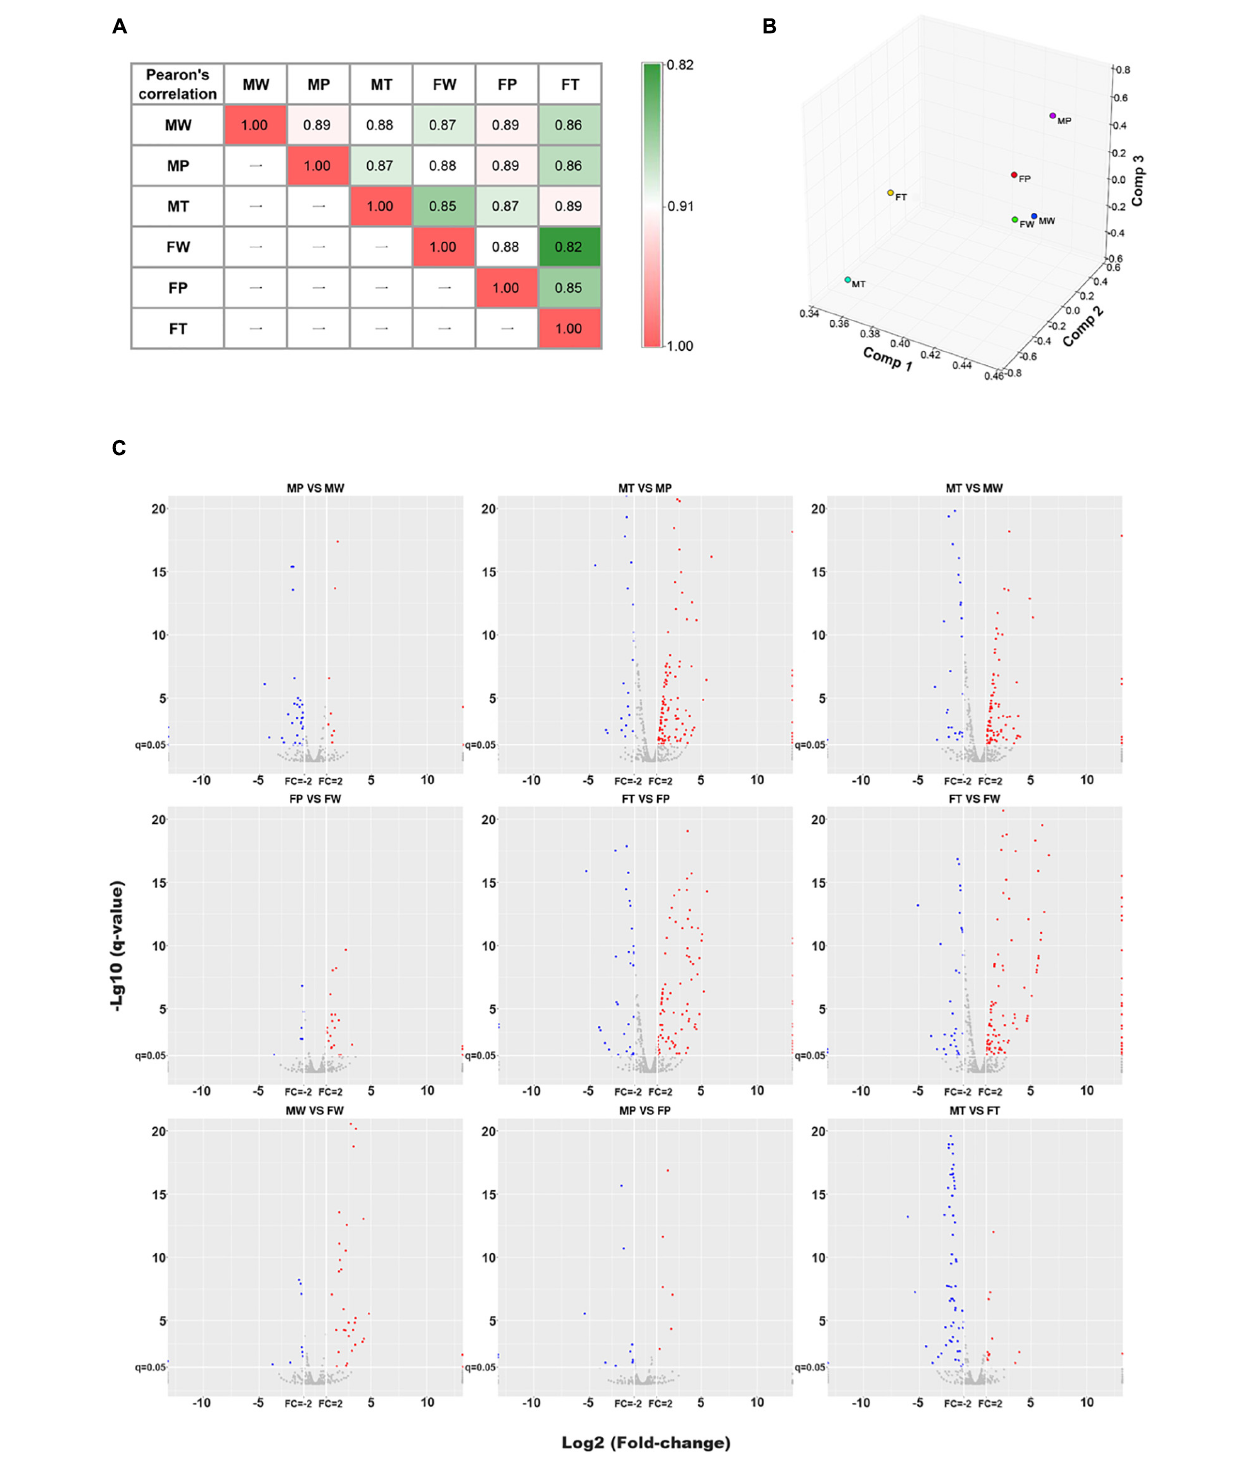
FIGURE 1 | The Pearson’s correlation, PCA and DEMIRs analysis for microRNA omics data. (A) Heatmap of the Pearson’s correlation (R2) analysis of miRNAomics dataset. Values denote the Pearson correlation coefficients. (B) Principal component analysis (PCA) calculation results are expressed as 3D scatter plot. (C) Volcano plot of pairwise comparisons. Red and blue colors represent relatively up- and down-regulated miRNAs, respectively. MW and FW, wild-type liver tissues of males and females, respectively; MP and FP, peri-tumor tissues of males and females, respectively; MT and FT, hepatic tumor tissues of males and females, respectively.